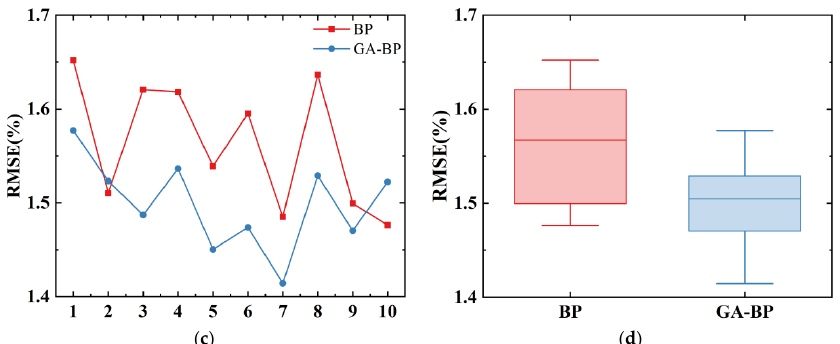
Figure 10. The prediction results of five test groups for slip_ y using BP and GA-BP: ( a ) the line charts of MAE; ( b ) the boxplots of MAE; ( c ) the line charts of RMSE; ( d ) the boxplots of RMSE.